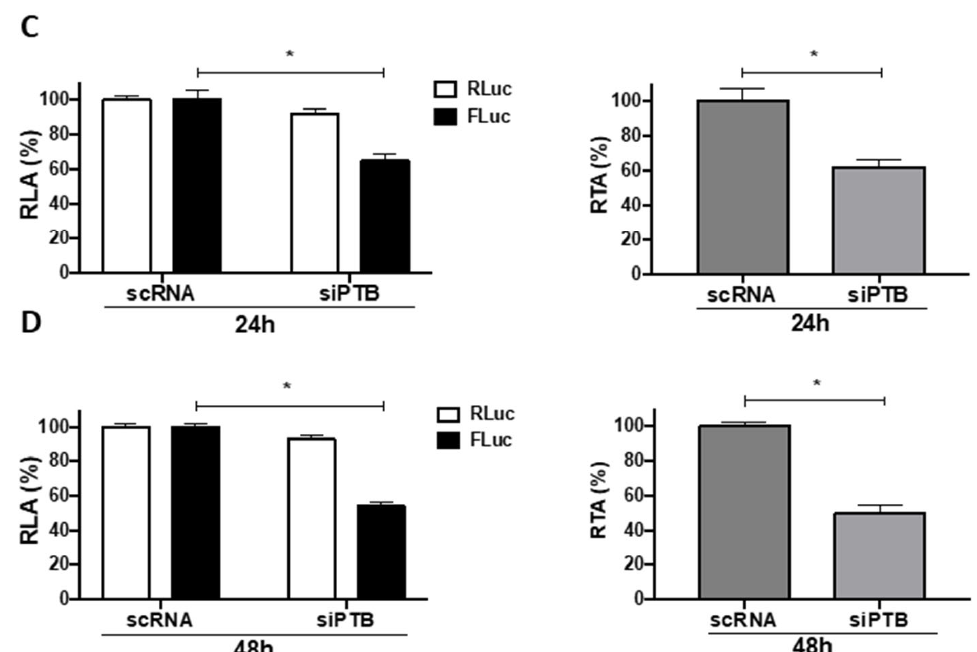
Figure 1. PTB1 binds to the 5 (cid:48) UTR of the HCV mRNA and modulates HCV IRES activity. ( A ) Binding curves of 32 P-labeled in vitro synthesized HCV 5 (cid:48) UTR ( (cid:78) ), EMCV 5 (cid:48) UTR ( • ), or HIV-1 5 (cid:48) UTR ( (cid:4) ) to purified His-PTB1 [38,56]. Data were fitted to the non-linear regression curve for specific binding with Hill slope. ( B , C ) HuH-7 cells were transfected with a scrambled (sc) RNA or a siRNA designed to target PTB mRNA(siPTB), together with the dl HCV IRES plasmid, as indicated in Material and Methods. ( B ) Upper panel: Schematic representation of the Renilla luciferase (RLuc) and firefly luciferase (FLuc) bicistronic constructs used in this study. Knockdown of PTB 24 and 48 h after transfection was confirmed by Western blotting (lower panel) using an anti-PTBP1 antibody. ( C , D ) RLuc and FLuc activities were measured 24 h ( C ) and 48 h ( D ) post-transfection and expressed relative to the scRNA control set to 100% (RLA: relative luciferase activity, left panels) or as relative translational activity (RTA), which corresponds to the [FLuc/RLuc] ratio (right panel). Values shown are the means ( ± SEM) of eight independent experiments, each conducted in duplicate. Statistical analysis was performed by the ANOVA test, followed by Sidak’s multiple comparisons tests; * p < 0.05 vs. the negative